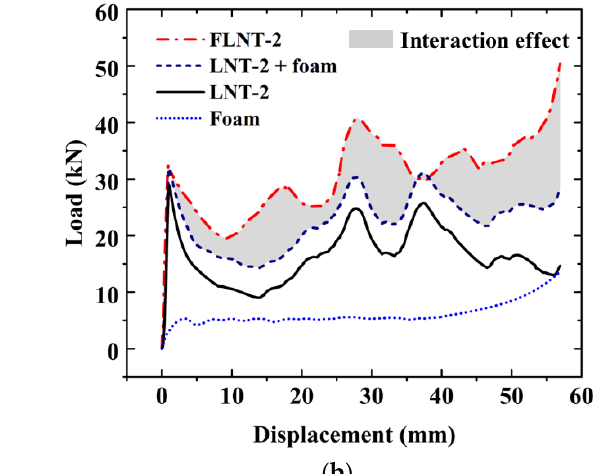
Figure 6. Deformation modes of foam-filled tubes under axial compression test: ( a ) FUT; and ( b ) FLNT-2.